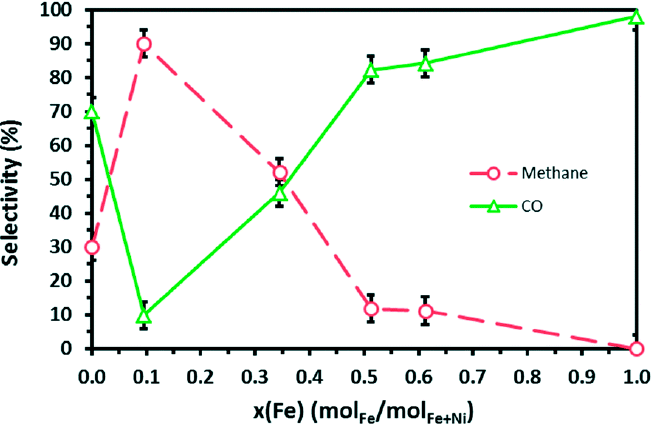
Figure 4. Effect of Fe content on CH 4 ( ○ ) and CO ( △ ) selectivity in comparison to sole metals. The highest methane selectivity, with 90%, was achieved for the catalyst containing 10% Fe. Reproduced with permission from [39]. Copyright: Royal Society of Chemistry, London, UK, 2018.